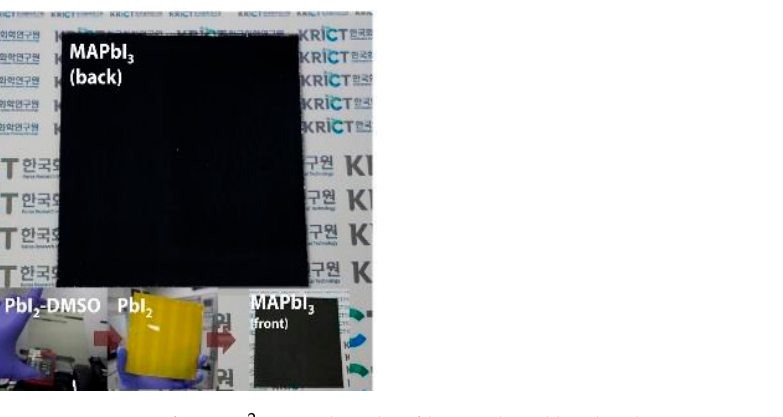
Figure 4. Picture of a 144 cm 2 S2S perovskite module. Copyright Reproduced with permission from Reference [4].